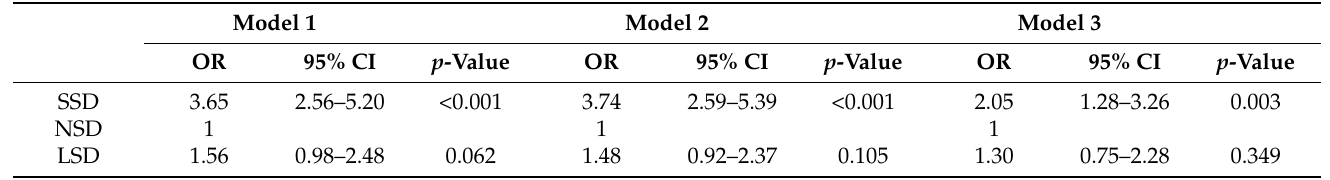
Table 3. Association between sleep duration and suicide attempts.